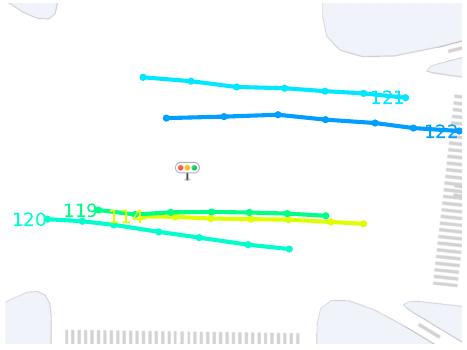
Figure 7. The vehicle trajectories at intersections over